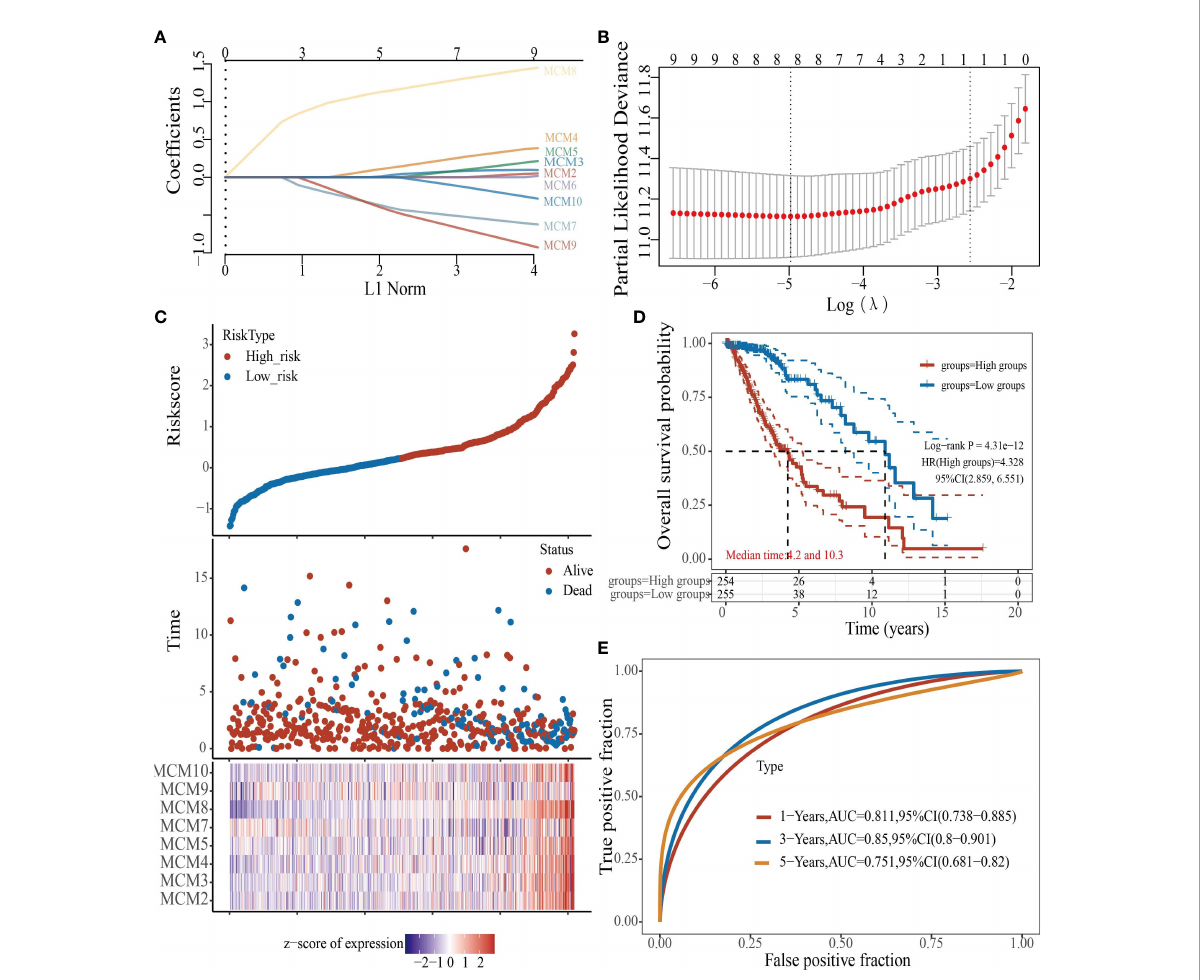
FIGURE 8 Construction of a prognostic MCMs model in glioma. (A) LASSO analysis of the expression pattern of the 9 MCMs. (B) Plots of the ten-fold cross-validation error rates. (C) Distribution of risk score, state of existence, and MCMs expression in glioma. (D, E) OS for glioma patients in the high-/low-risk group and the ROC curve of measuring the predictive